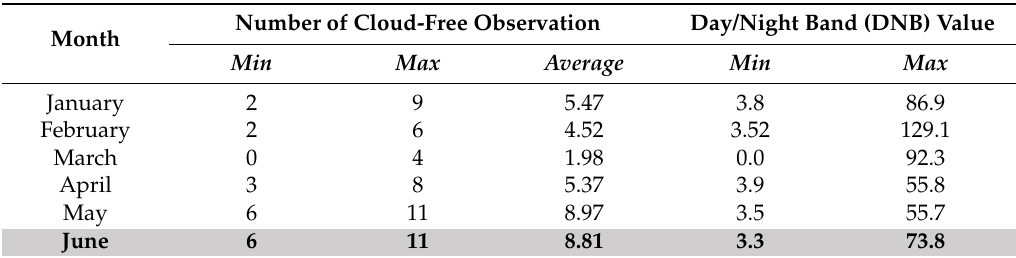
Table 4. Average number of cloud-free observations in VIIRS 2015 monthly composites for the Cuenca City study area (grey indicating eventually selected monthly composite).